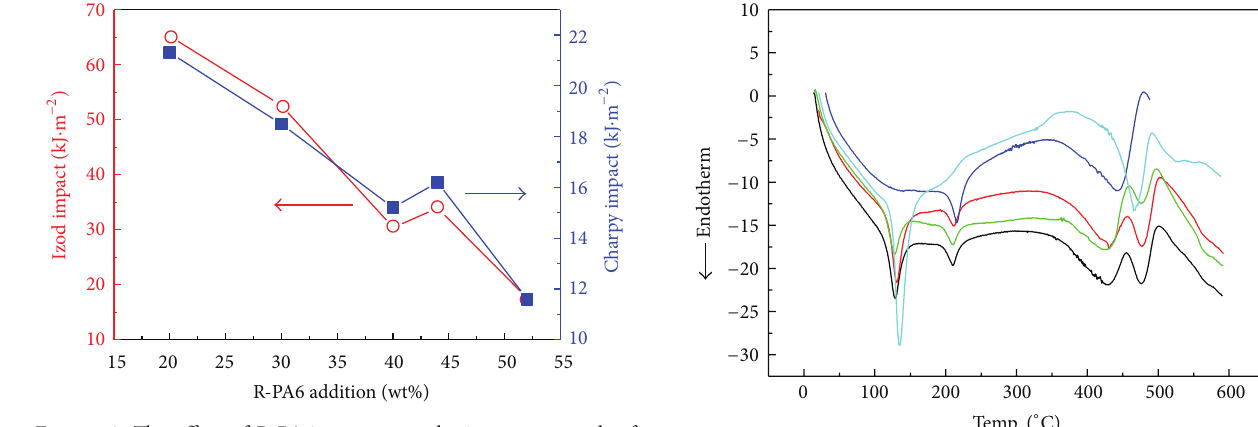
Figure 2: The effect of R-PA6 content on the impact strength of UHMWPE/R-PA6/HDPE-g-MAH.